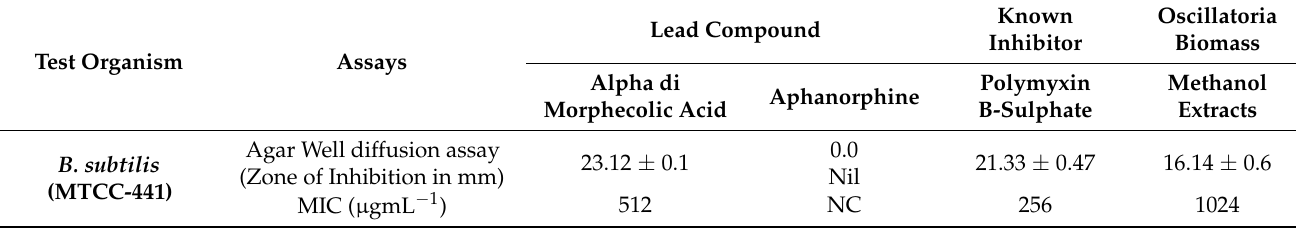
Table 3. In-vitro validation of lead compound and